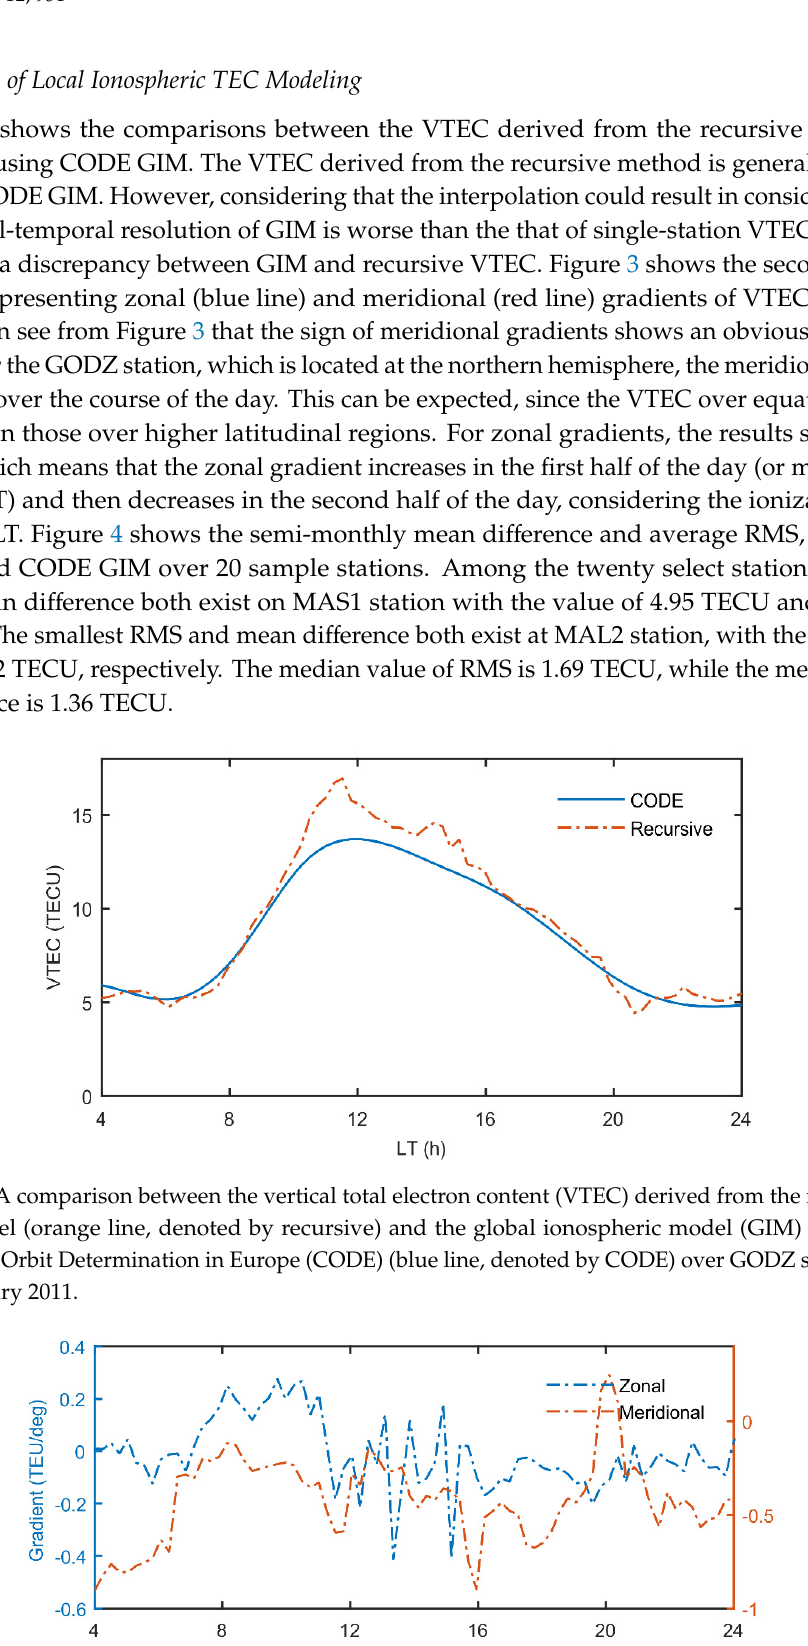
Figure 4. Semi-monthly mean difference and root mean square (RMS) with respect to interpolated CODE GIM over 20 sample stations. The horizontal axis shows the name of stations. 3.3. Reference Station Selection